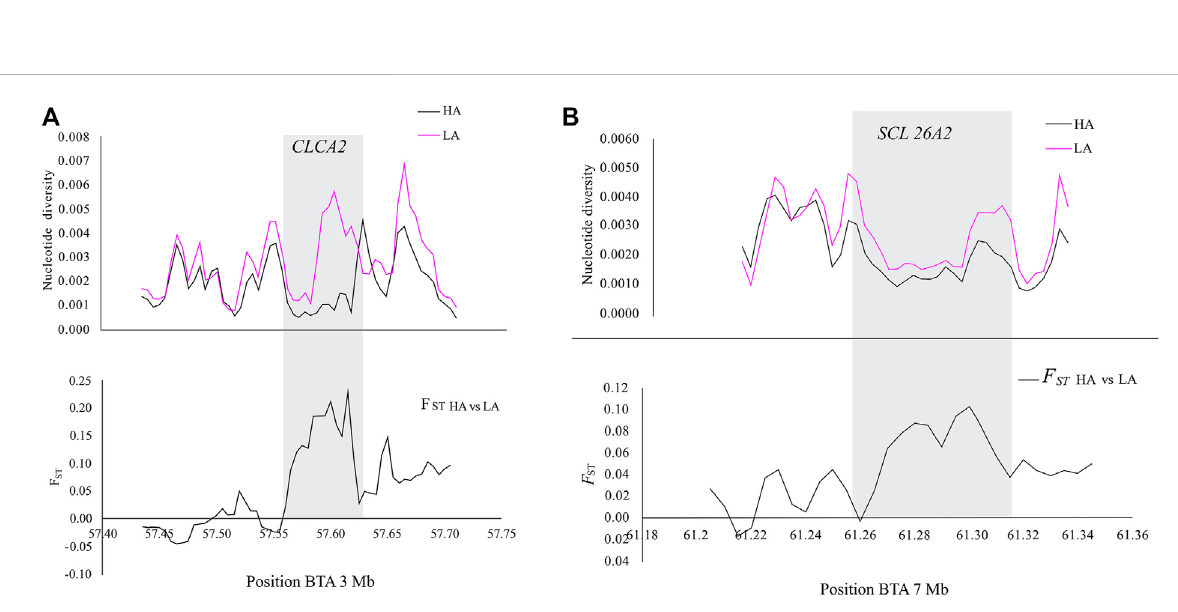
FIGURE 9 Plots of the nucleotide diversity within and F ST values between the genomic regions of CLCA2 (A) and SCL26A2 (B) in high-altitude (HA) and low-altitude (LA) cattle